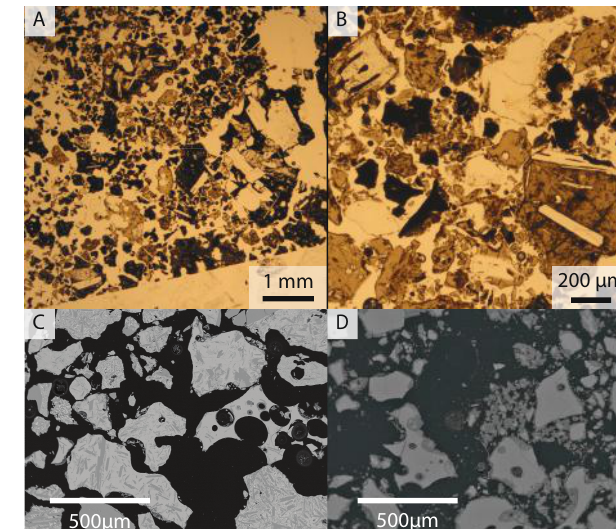
Figure 9: Plane polarized images of tephra samples TNG-19 [A] and TNG-22 [B] and BSE images of TNG-19 [C] and a BSE im- age of hyaloclastite, TNG-29 [D]. Tephra and hyaloclastite alike and larger, commonly phenocryst-bearing